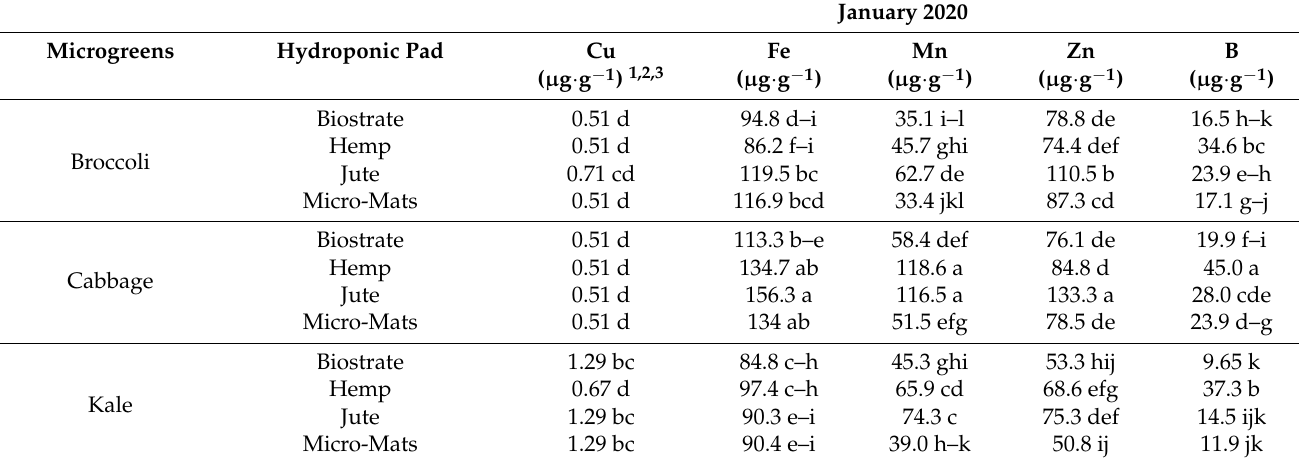
Table 9. Micronutrient concentrations in five microgreens affected by the interaction between species and hydroponic